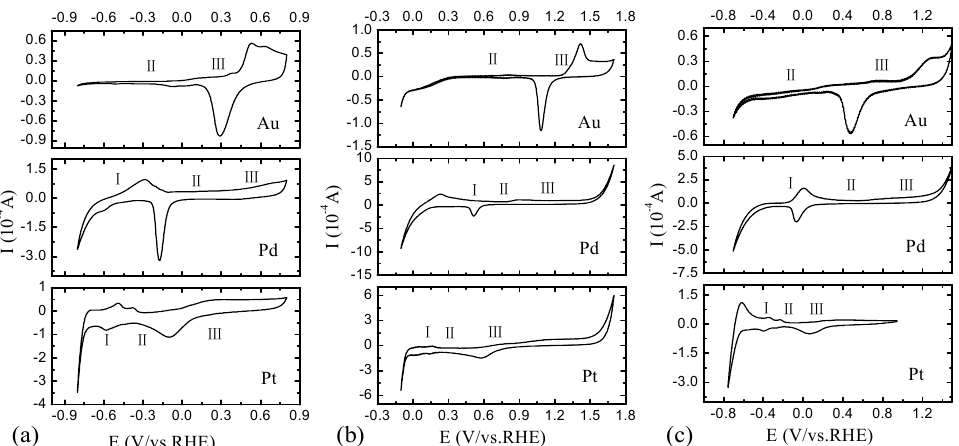
Figure 3. Cyclic voltammograms (100 mV s − 1 ) of metal disk electrodes in different electrolytes with N 2 saturated: 0.1 M KOH ( a ); 0.1 M HClO 4 ( b ); and 0.05 M K 2 SO 4 ( c